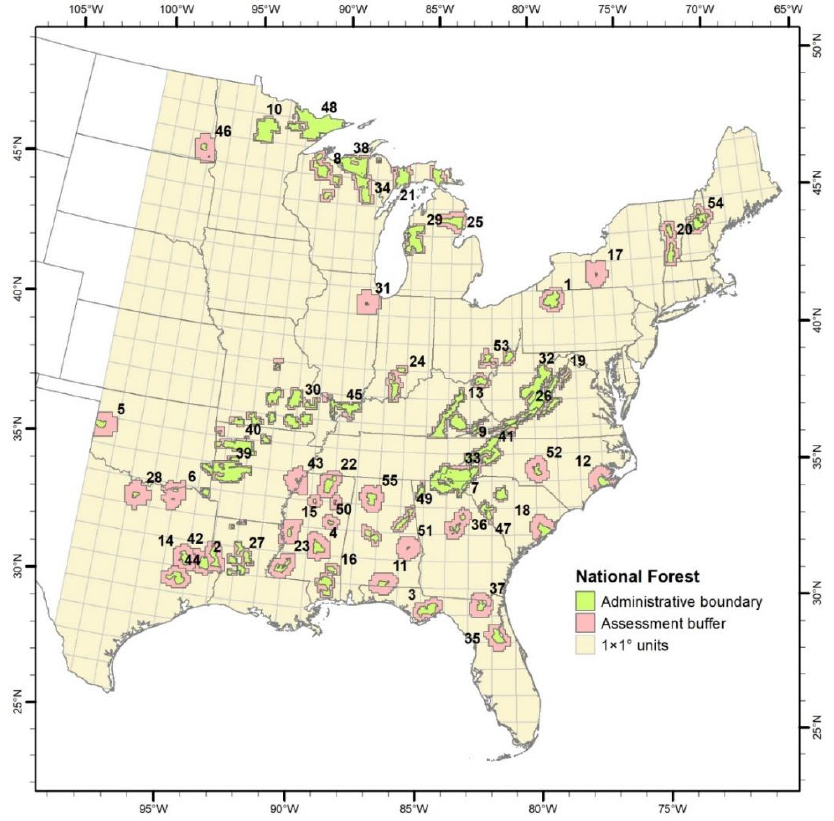
Figure 1. The National Forests and Grasslands (NF), superimposed on the 1 × 1 degree grid of the eastern US. Those NF locations occupying <8000 km 2 were buffered to attain at least that size, in order to access sufficient FIA plots for reasonable model outputs. The names of the forests or grasslands to which the numbers correspond are presented in Table 3. The 469 1 × 1 degree units are also depicted and provide a wall-to-wall coverage. The individual files are named by their southeast boundary, such that, for example, a GPS coordinate of 42.44°N latitude, −82.55°W longitude will be named S42_E82.